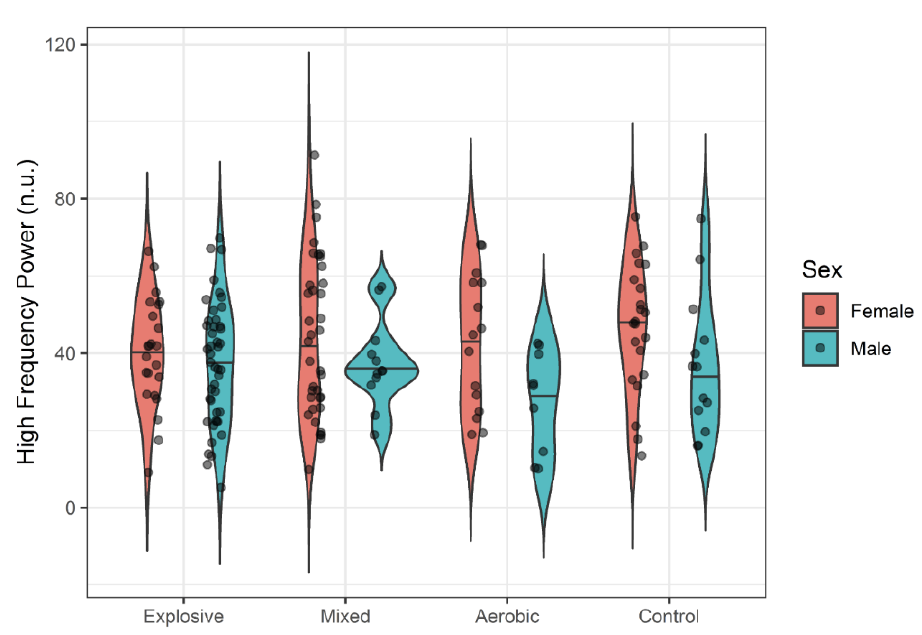
Figure 1. LF by Athlete Type.